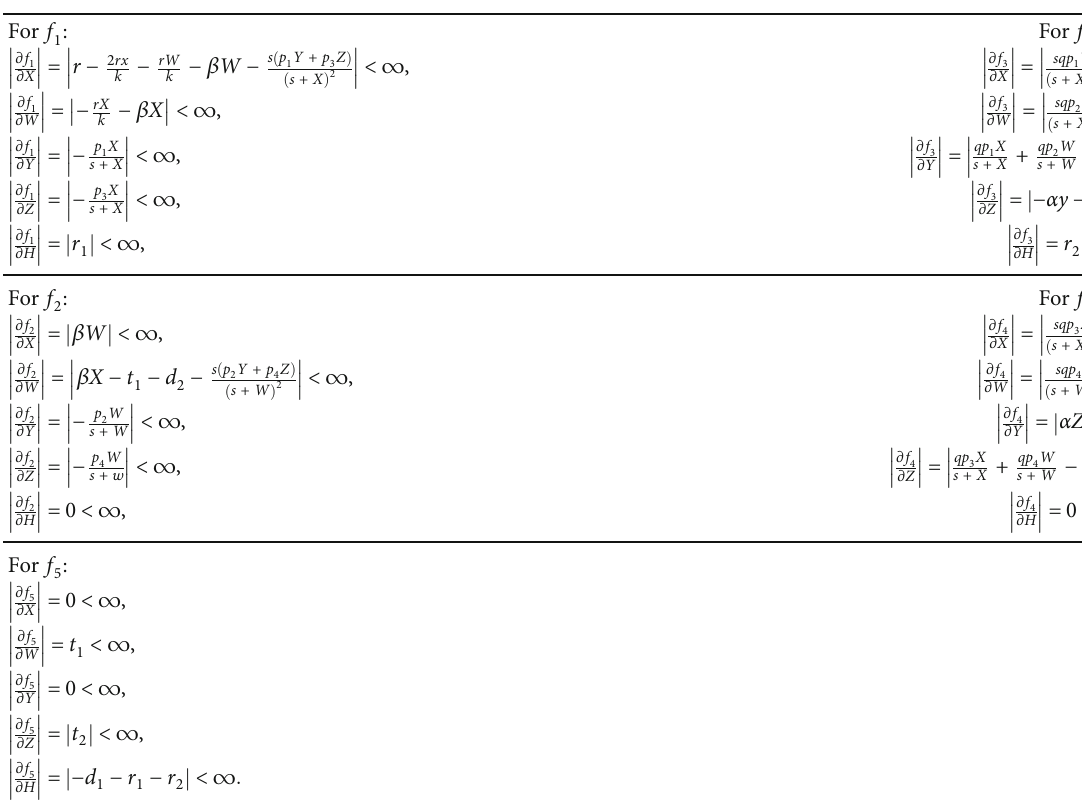
Table 1: Partial derivatives.